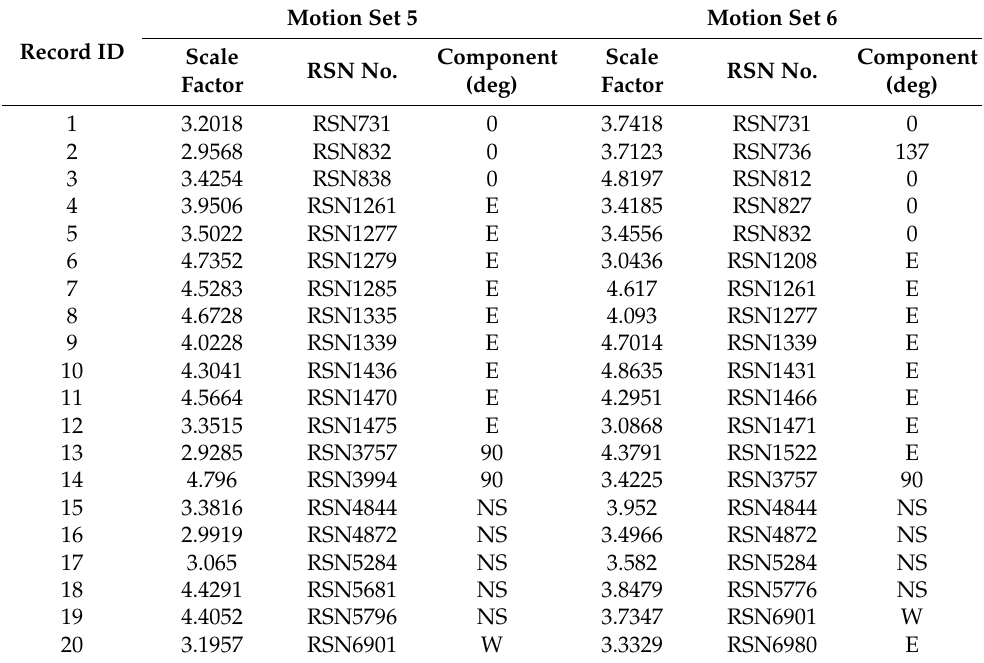
Figure A4. Mean spectra of IGMs selected from motion sets 3 and 4 with different selection procedures. Table A3. Details of IGMs of motion sets 5 and